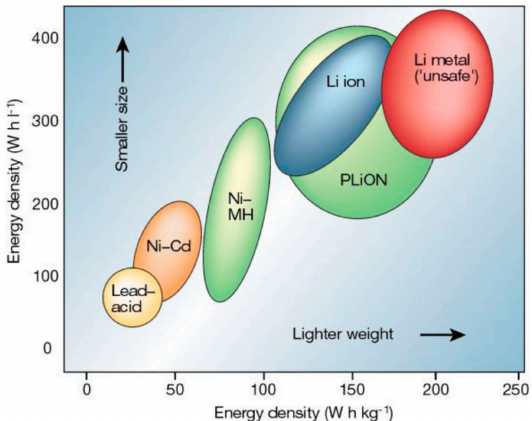
Figure 1. Available ESS characteristics [9]. Reproduced from [9], MDPI/energies 2019.